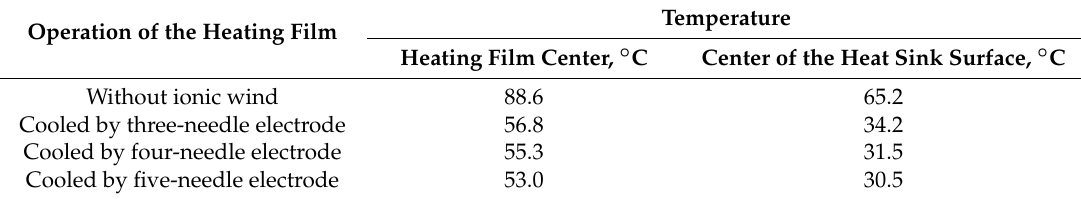
Table 4. Temperature of the heating film center and center of the heat sink surface facing the impingement of ionic wind. (Applied voltage of 22 kV in negative corona